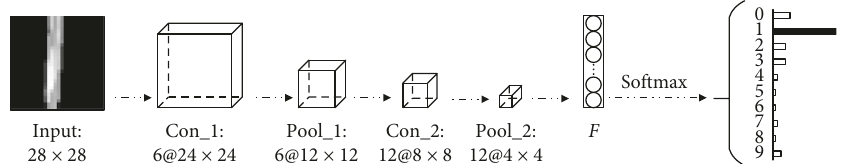
Figure 7: Convolution neural network structure of character recognition, included a input layer, two convolution layers, two pooling layers, and a fully connected layer.